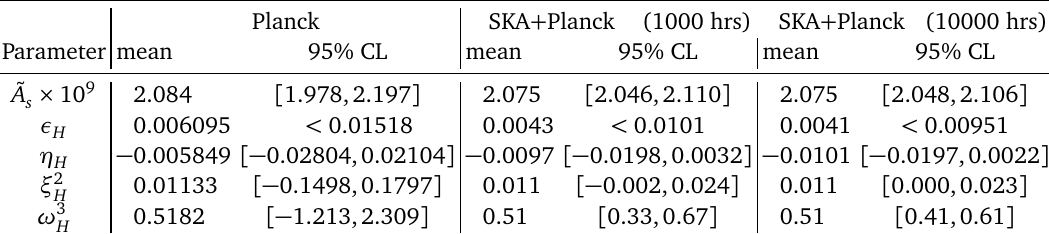
Table 3: Mean values and 95% CL error bars for the slow-roll parameters from Planck 2018 data and combined Planck plus SKA with 1000 hrs or and 10000 hrs observation time, marginalized over cosmological paramers, and corresponding to Fig. 10. Planck SKA + Planck (1000 hrs) SKA + Planck (10000